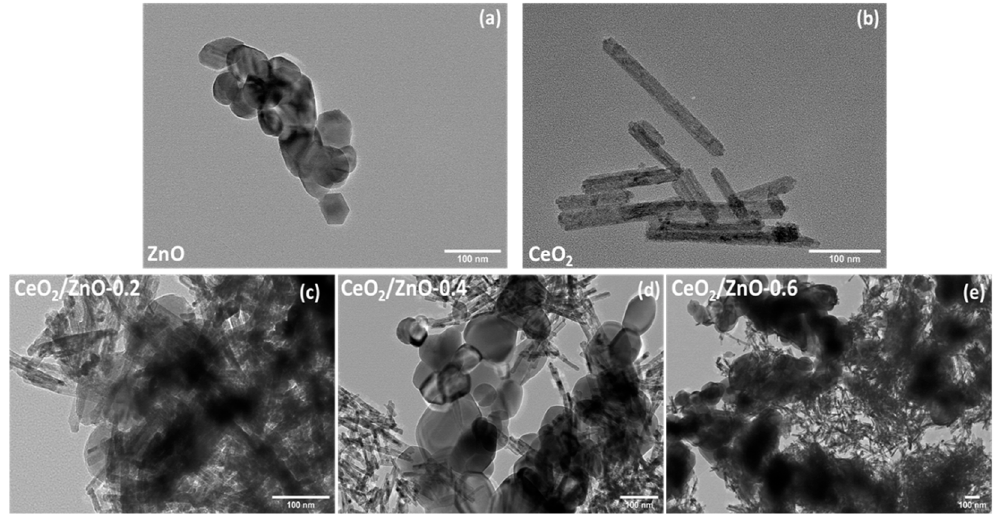
Figure 3. TEM images of ( a ) ZnO, ( b ) CeO 2 , ( c ) CeO 2 /ZnO–0.2, ( d ) CeO 2 /ZnO–0.4 and ( e ) CeO 2 /ZnO– 0.6.